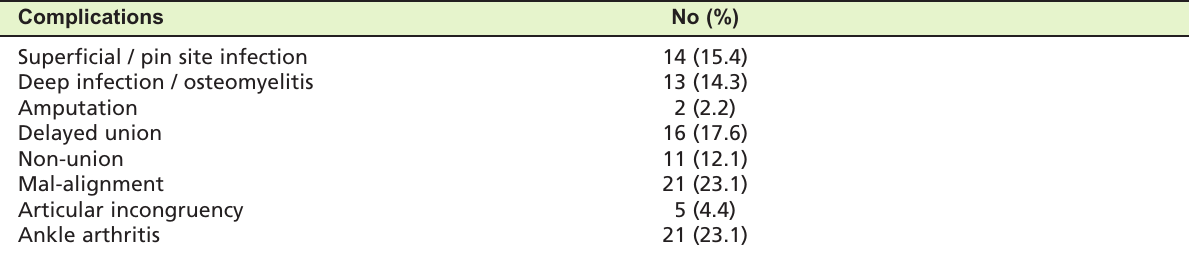
Complications of distal tibia Table II: